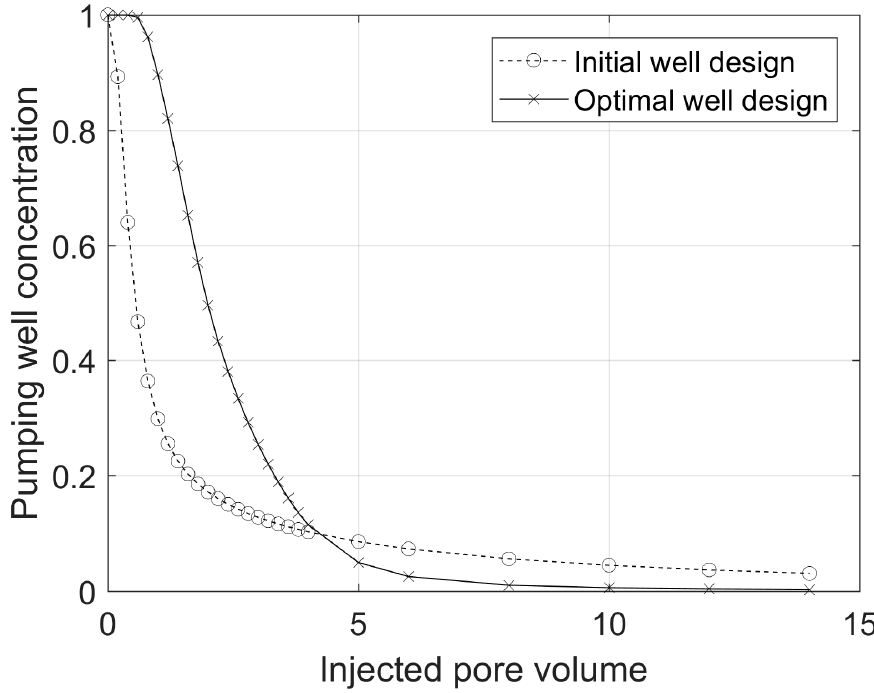
Figure 11. Breakthrough curves at the pumping well for the P&T initial and optimal designs in the two-dimensional heterogeneous aquifer.